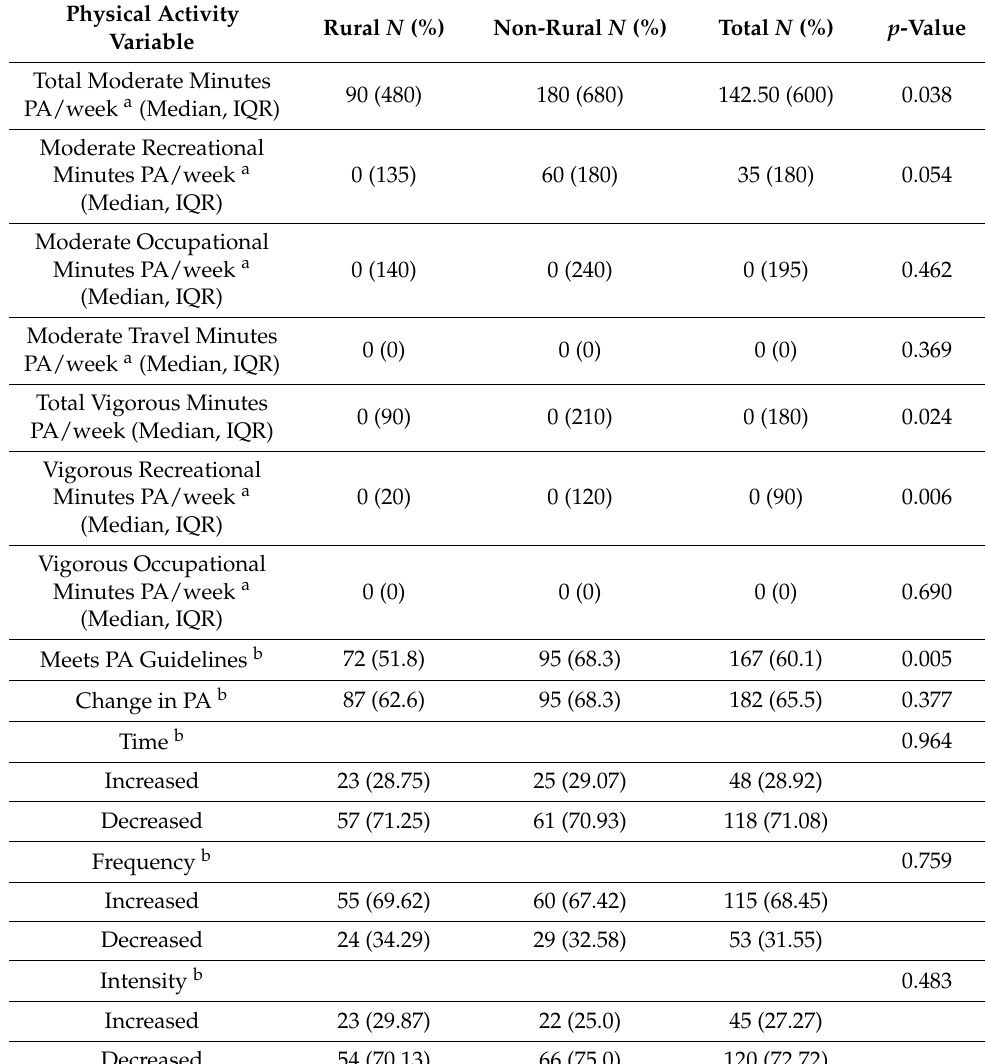
Table 2. Physical activity variables split by